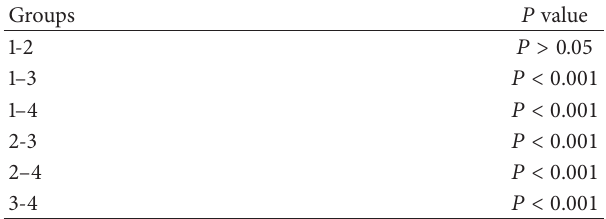
Table 2: Comparison of the